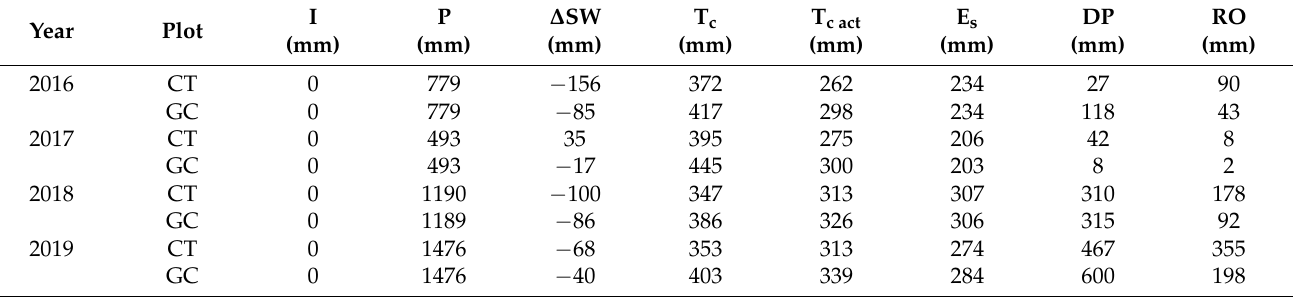
Table 8. Components of the soil water balance in the Monferrato plots.